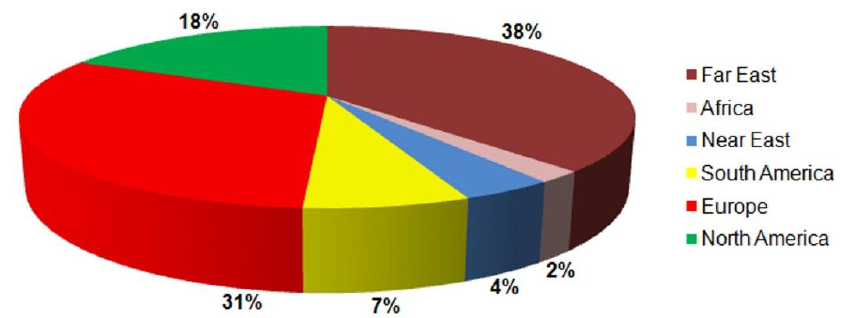
Figure 11. Worldwide consumption of zinc